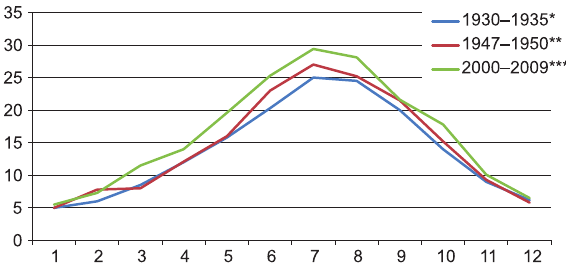
fig. 2. Temperature variation between 1930 and